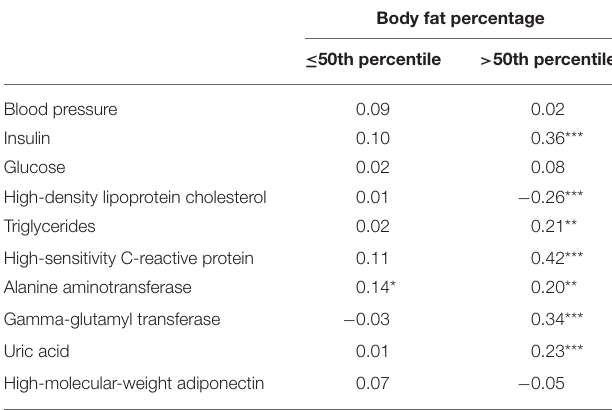
TABLE 1 | Partial coefficients of correlation between body fat percentage assessed by dual-energy X-ray absorptiometry and cardiometabolic risk factors among children below and above median of body fat